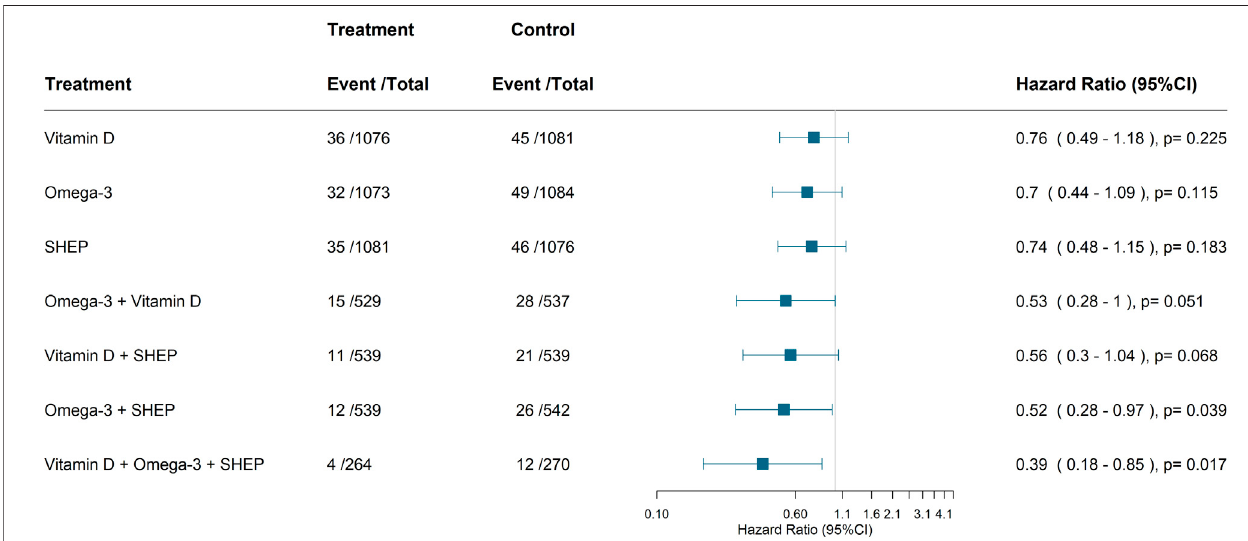
FIGURE 2 | Primary endpoint — effect of treatments on the prevention of any invasive cancer. Cox-proportional hazard model adjusted for history of cancer, sex, BMI,priorfall,age,andstudycenter.Thecomparisongroupisalwaysthegroupthatdoesnothavetherespectivetreatment(s)ofinterest.Forallthreetreatments,itisthe group who received only the placebo. All veri fi ed new invasive cancer cases ( n = 81) among all 2,157 participants. Abbreviation: SHEP, Simple home exercise program.